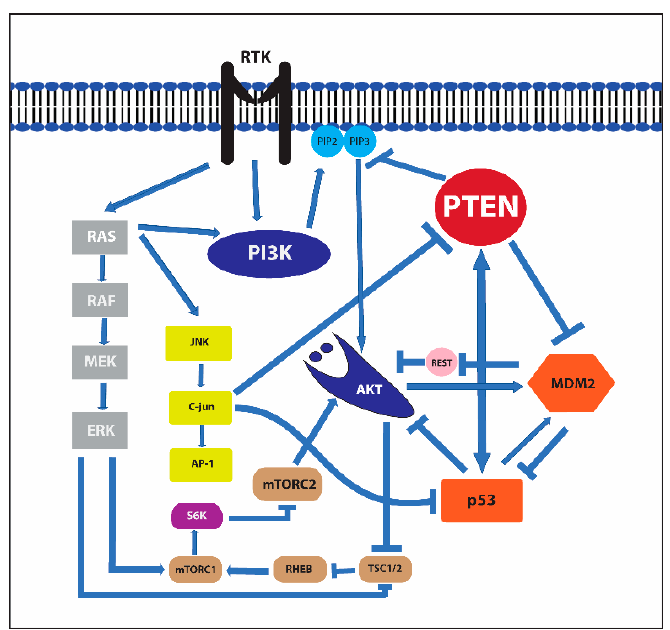
Figure 3. Receptor tyrosine kinase, murine double minute 2 (MDM2), mammalian target of rapamycin (mTOR), and c-Jun N-terminal kinase (JNK) signaling pathways and their interactions.